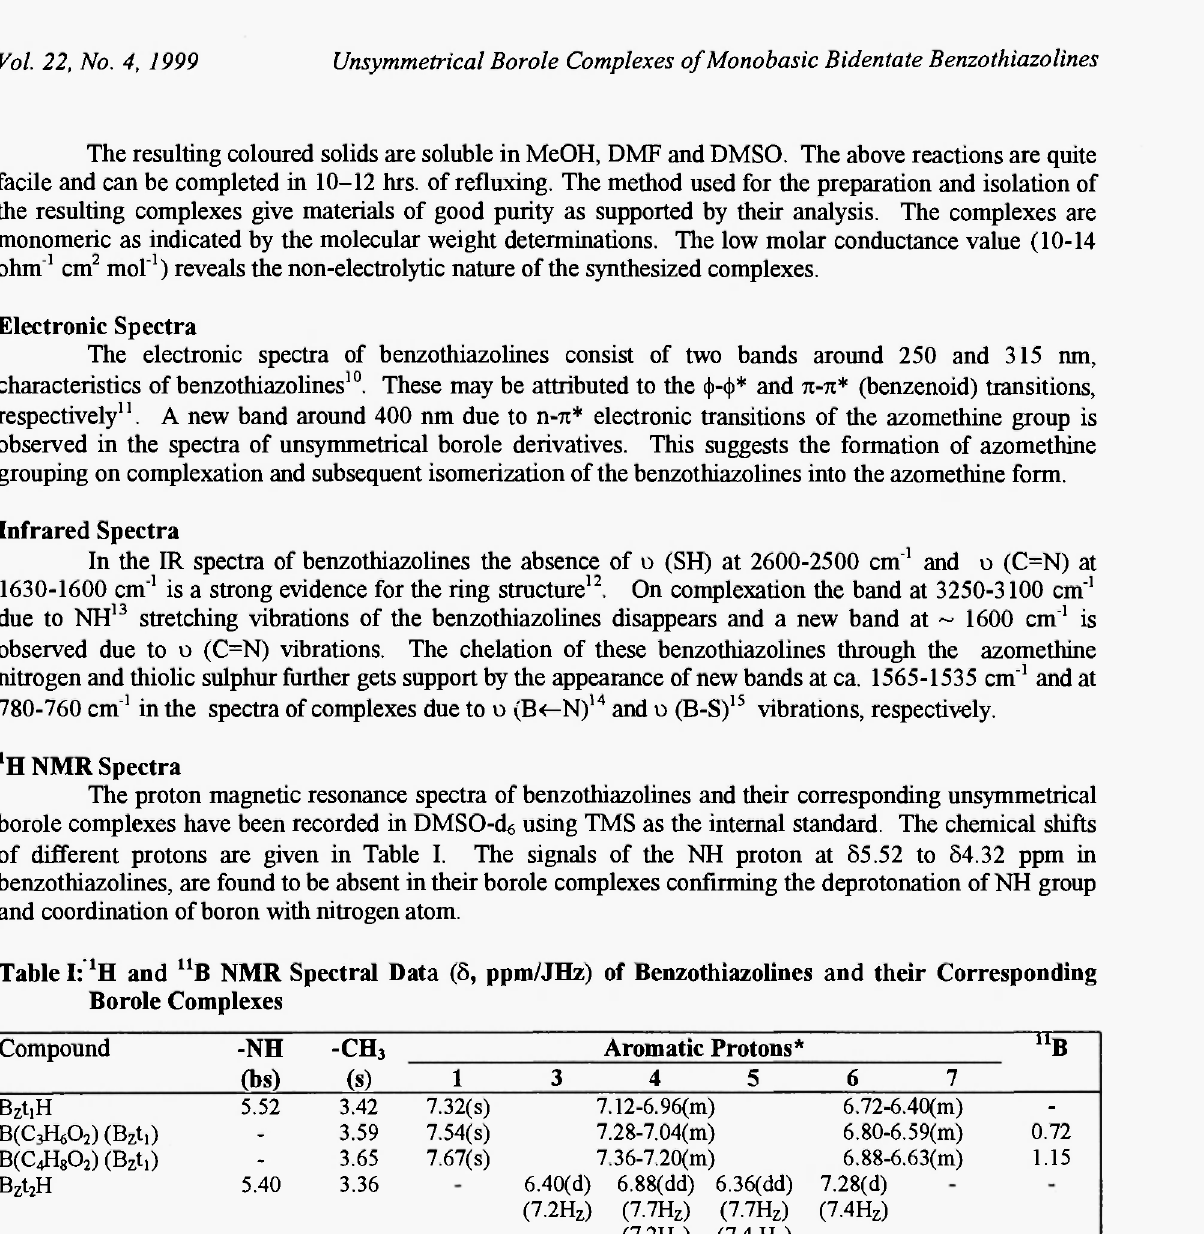
Table I: X H and U B NMR Spectral Data (δ, ppm/JHz) of Benzothiazolines and their Corresponding Borole